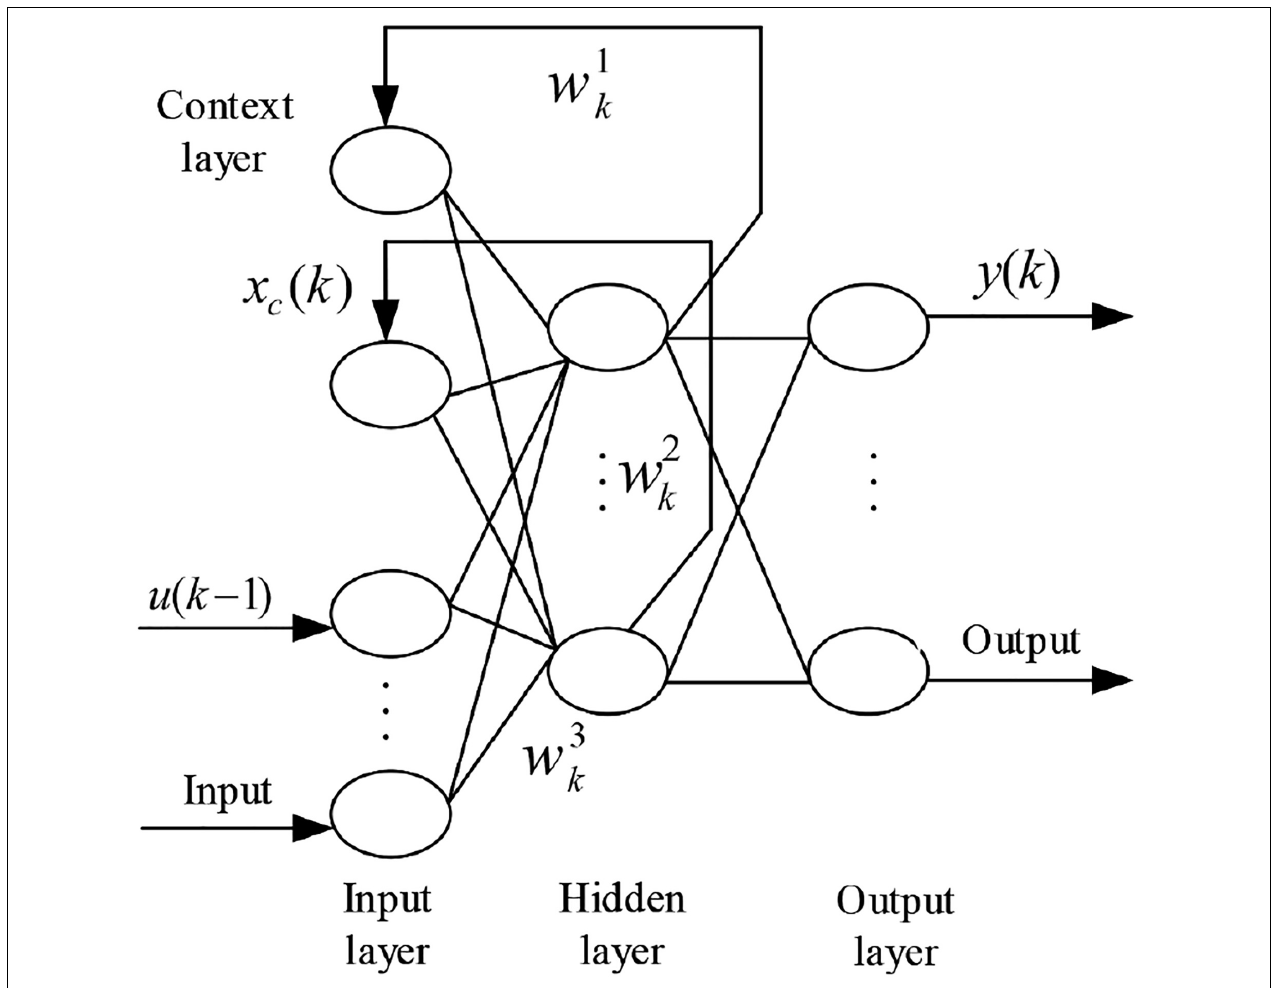
FIGURE 7 | The structure of Elman neural network